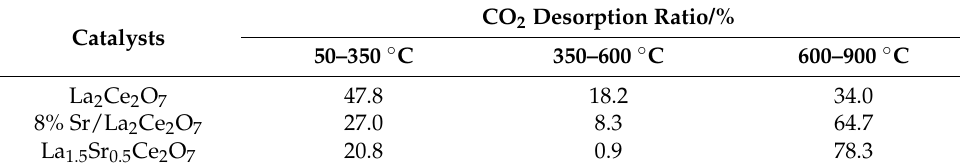
Figure 10. CO 2 -TPD profile of the indicated catalysts [89] .